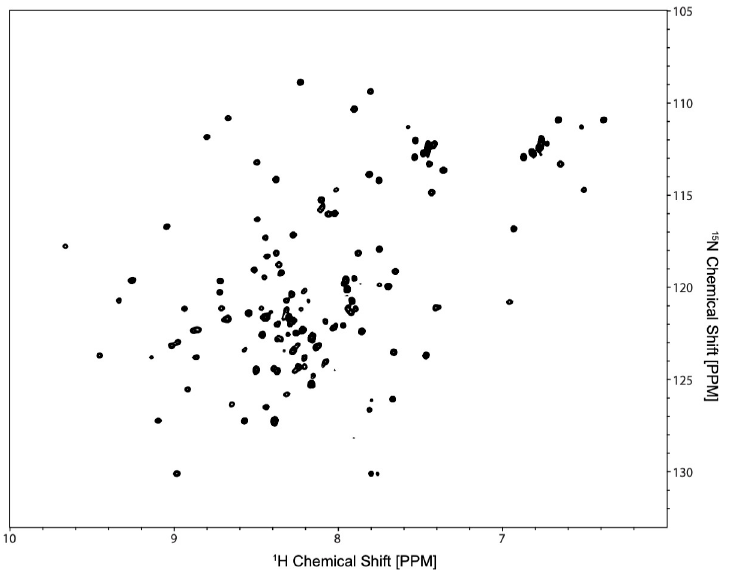
Fig 5. SUMO-G0S2 spectra. 15 NHSQC spectra from nitrogen-labeled SUMO-G0S2.